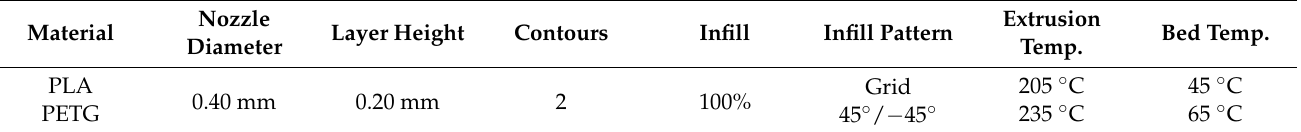
Table 1. 3D-printing process parameters.